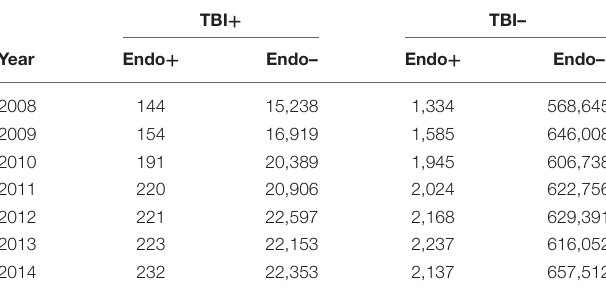
TABLE 2 | Contingency table of sample populations for